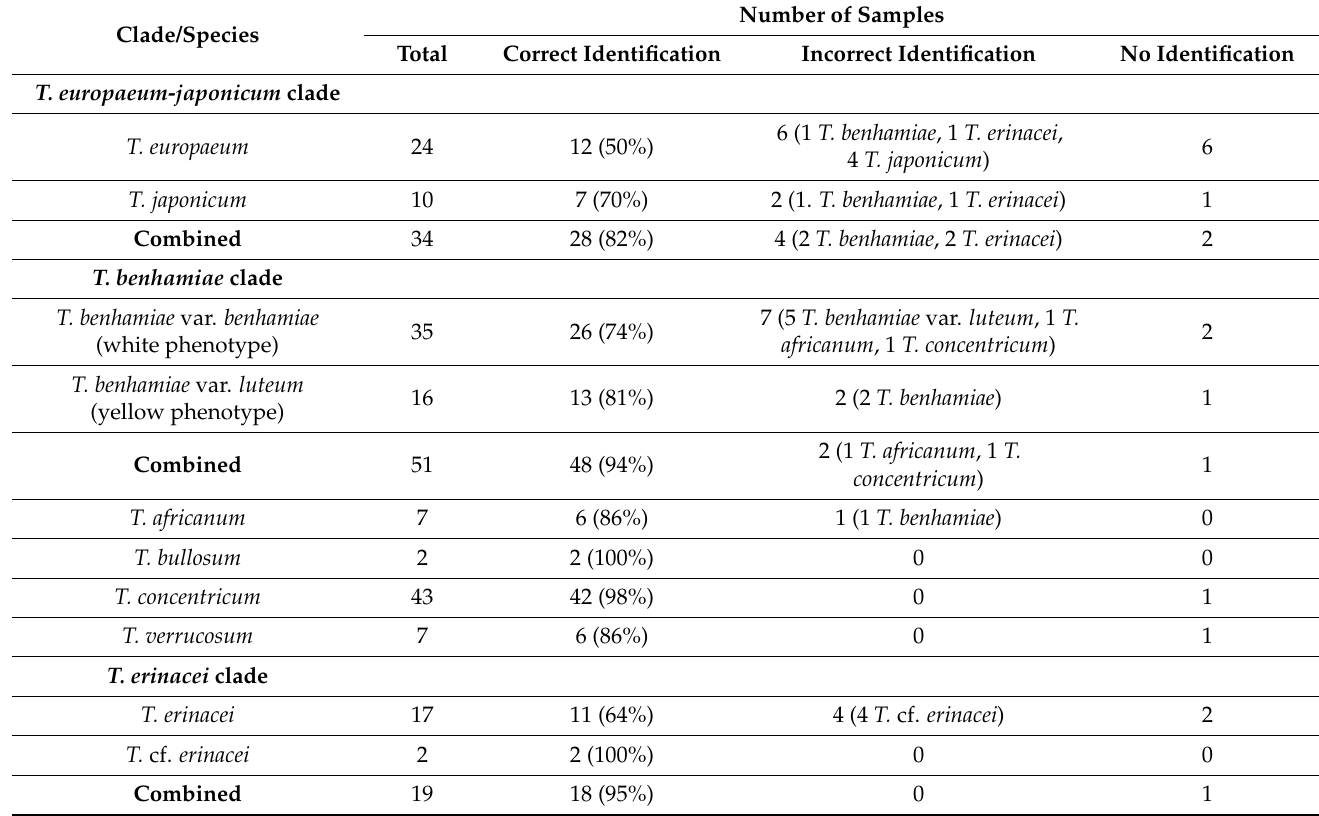
Table 1. Identification results of T. benhamiae complex species using MALDI-ToF mass spectroscopy. An identification was deemed valid when log scores were ≥ 1.7 and at least three out of the four replicates were identified as the same species, strains for which any of these criteria were not met were counted in the column ‘no identification’. When an identification did not match the identity based on ITS+BT genetical analysis, the identification was deemed an ‘incorrect identification.’ For certain clades (in bold) of closely related species/variants combined scores were calculated where identification was considered correct if the strain was identified as either one of the species/variants comprised in the